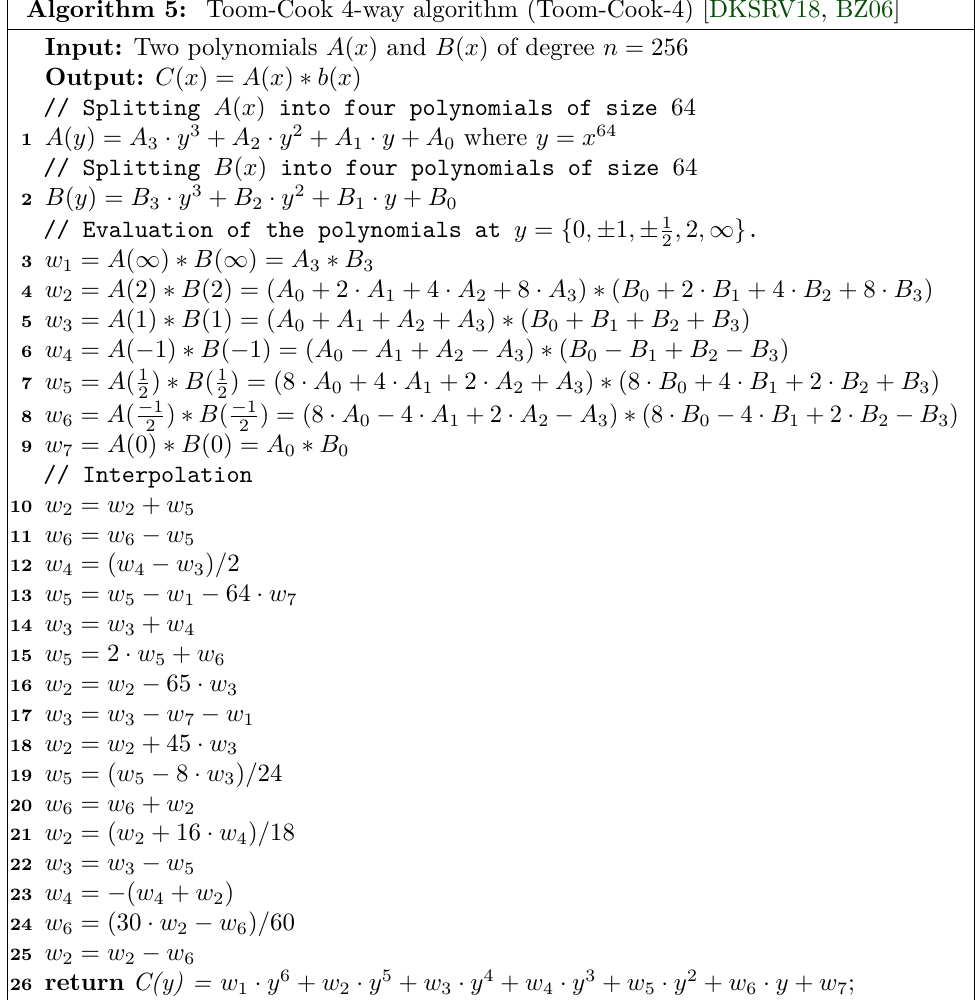
Algorithm 5: Toom-Cook 4-way algorithm (Toom-Cook-4) [DKSRV18,